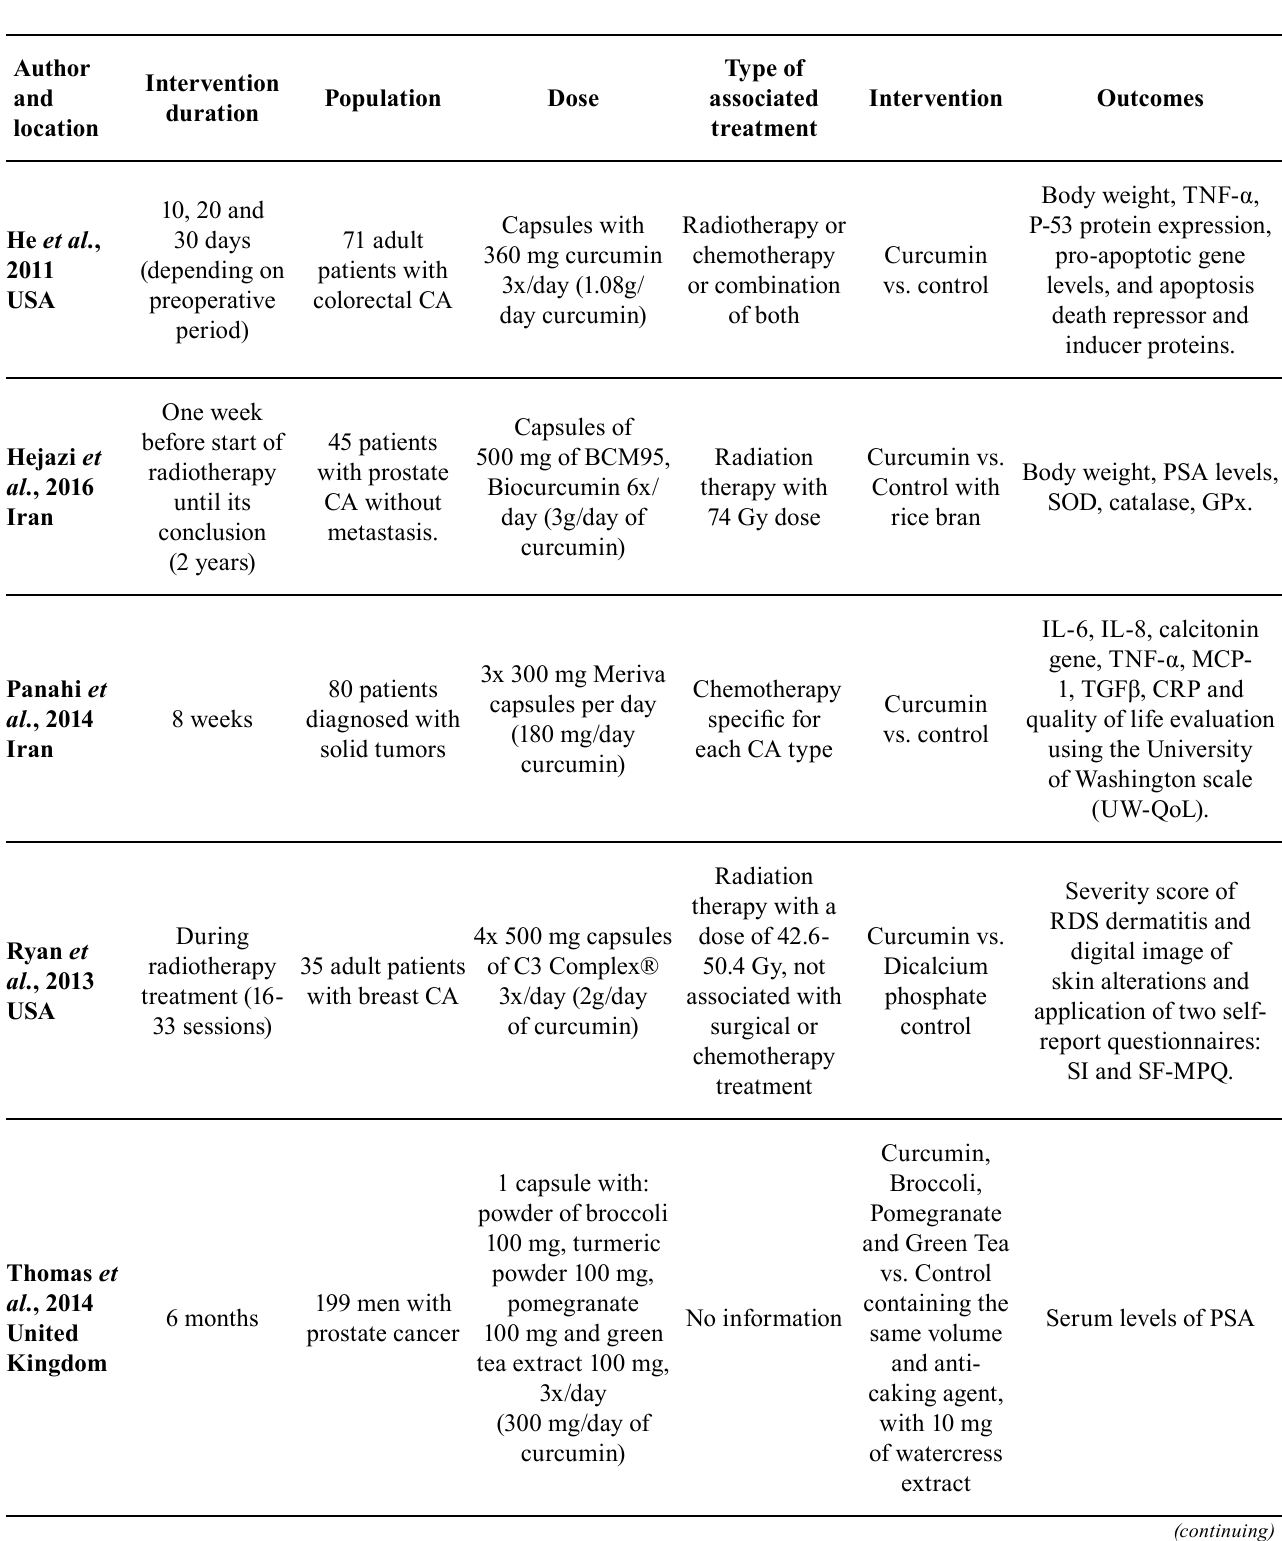
TABLE I – S ummary of characteristics of clinical